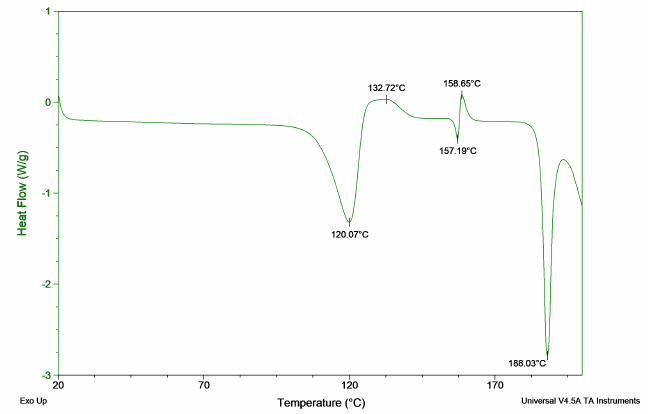
Figure 2. Differential scanning calorimetry (DSC) analysis of zolpidem tartrate showing an endother- mic peak at 120.07°C, a broad exothermic peak at 132.72°C, a fast polymorphic transition at 157.19°C and 158.65°C and finally a melting peak at 188.03°C, after which degradation is